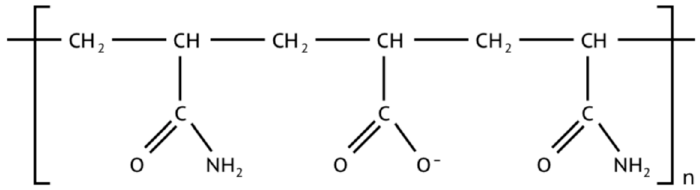
Figure 4. Molecular structure of partially hydrolyzed polyacrylamide .